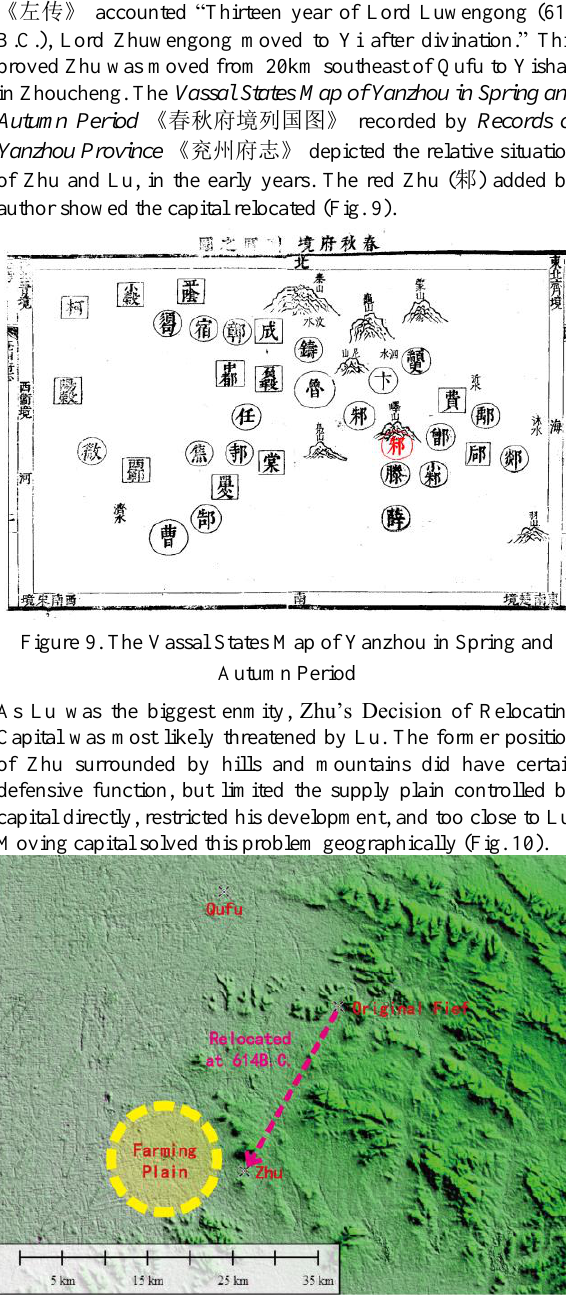
Figure 10. The situation analysis of Zhu’s two